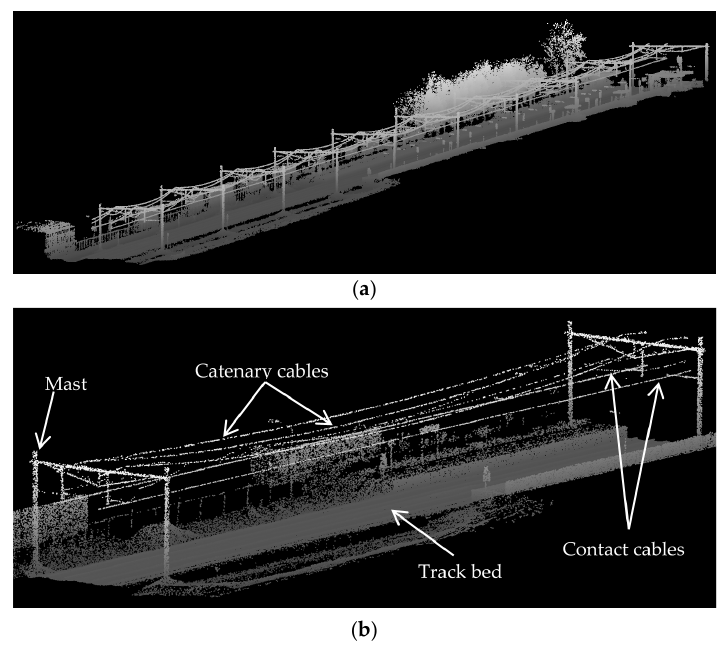
Figure 10. The dataset is depicted from two different views: ( a ) The entire dataset from an oblique view; ( b ) A finer representation of the railroad assets in this dataset. Sensors 2016 , 16 , 2112